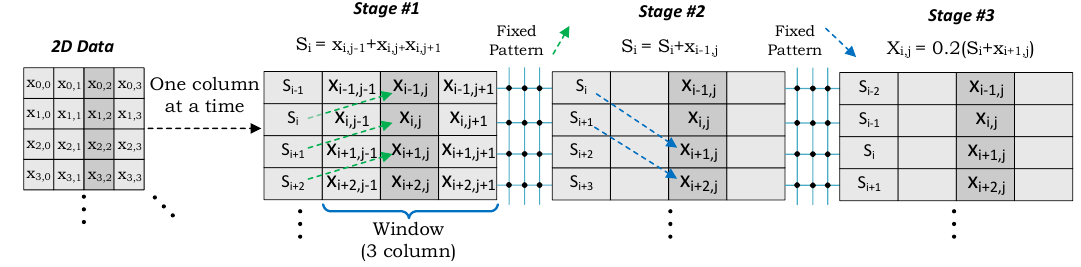
Figure 4. 2D Stencil implementation (5-point iteration) on the associative processor